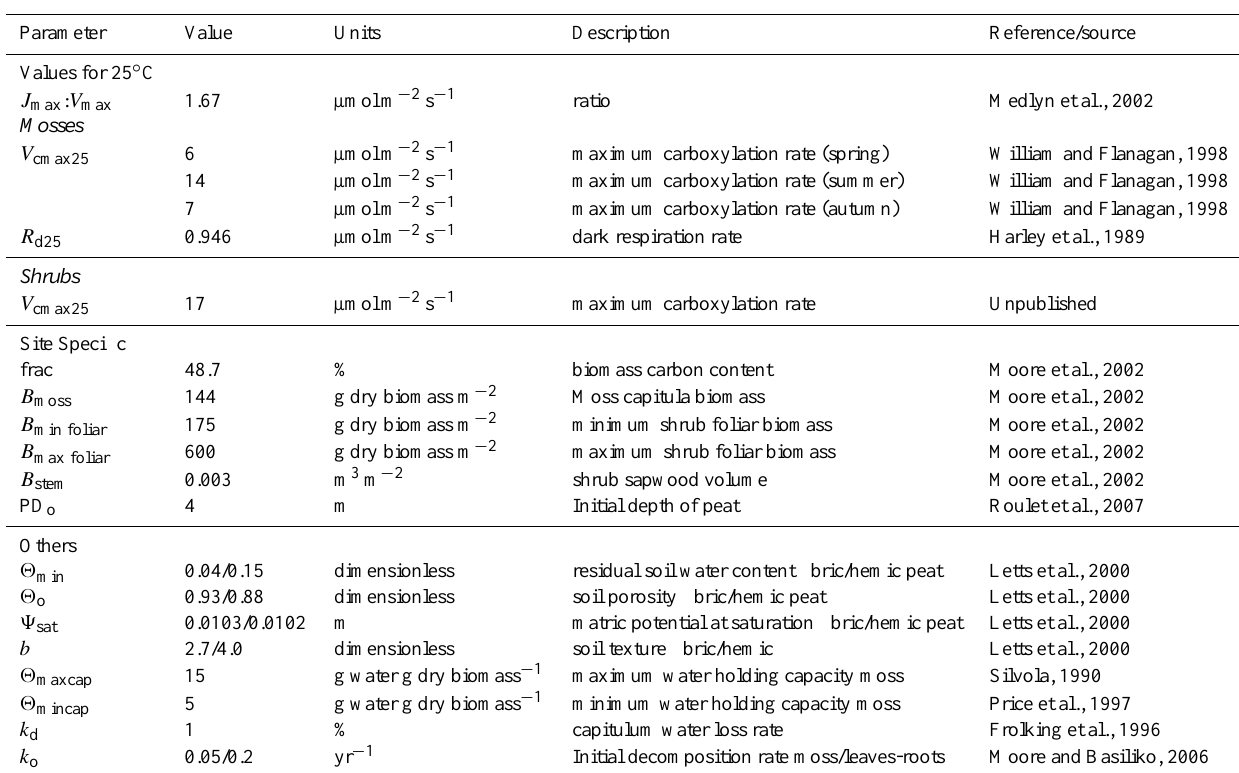
Table 1. Parameters and initial values used in MWM